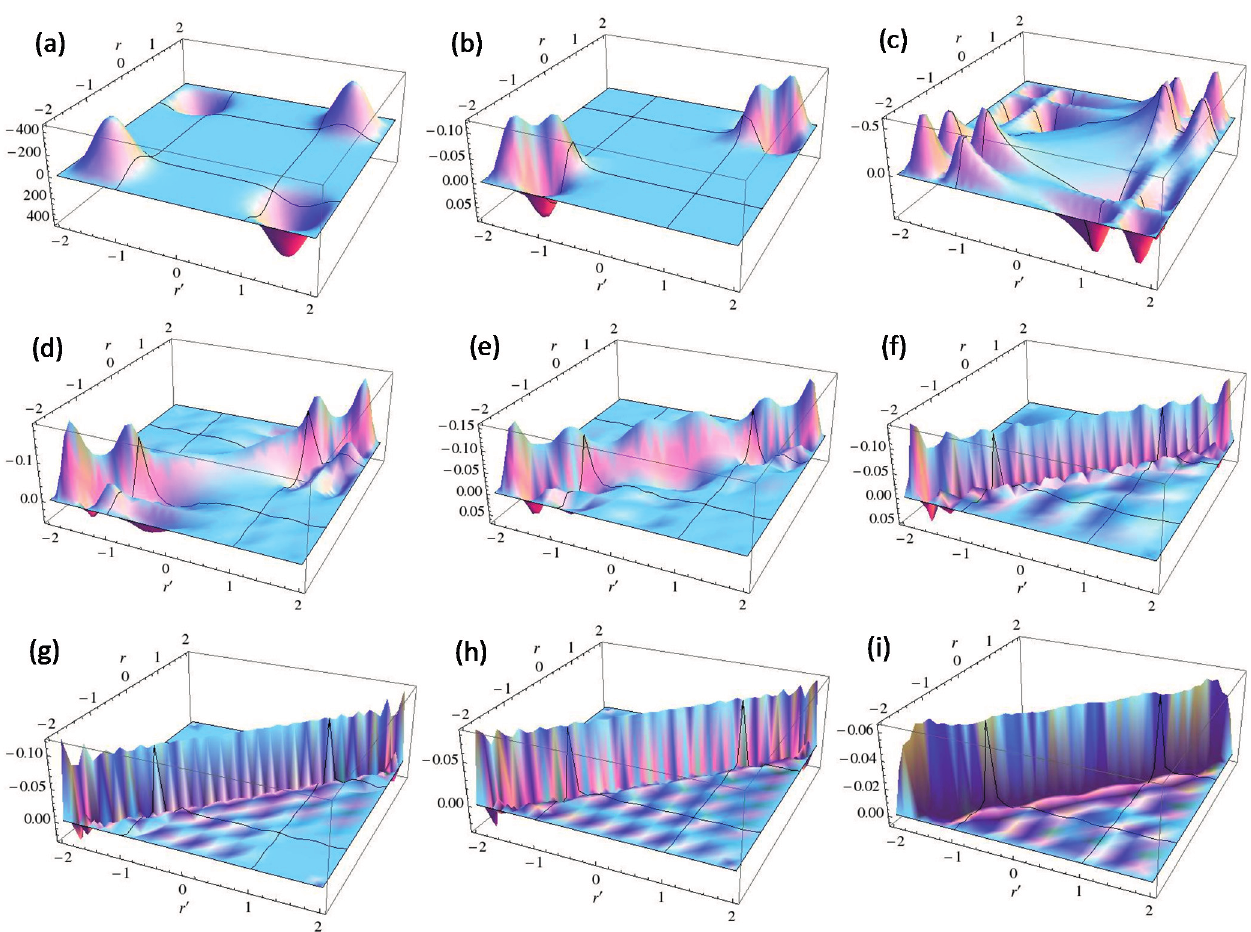
Figure 5. Plots of linear response functions of the double-well potential system (V 0 = 25) for various numbers of occupied orbitals (Nocc). ( a ) Nocc = 1; ( b ) Nocc = 2; ( c ) Nocc =